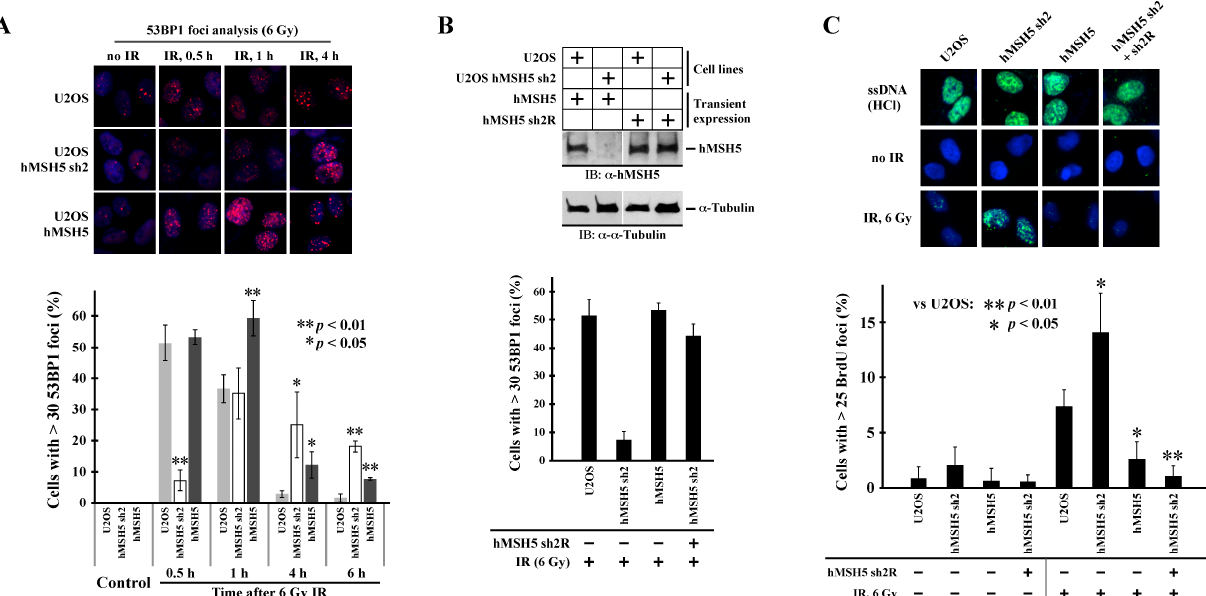
Figure 5. Effects of hMSH5 on IR-induced 53BP1 foci formation and DSB end resection. ( A ) Exami- nation of IR-induced 53BP1 foci formation in U2OS, U2OS/hMSH5 sh2, and U2OS/hMSH5 cells at 0.5, 1, 4, and 6 h after irradiation with 6 Gy IR. A representative image panel of 53BP1 foci for each cell line is provided. Thirty foci per cell were used as the cutoff to analyze the effect of hMSH5 on IR-induced 53BP1 foci formation. Bar graphs are used for data presentation, and asterisks are used to designate significant differences among all three cutoff categories. Error bars are standard deviations determined from three counts, each with 100 cells. ( B ) Rescuing of IR-induced 53BP1 foci formation by RNAi-resistant hMSH5 (sh2R) at 30 min post IR treatment. Upper panel shows immunoblotting analysis of RNAi-resistant hMSH5 expression in U2OS/hMSH5 sh2 cells. ( C ) Examination of ssDNA formation in U2OS, U2OS/hMSH5 sh2, U2OS/hMSH5, and hMSH5-complemented U2OS/hMSH5 sh2 cells. A panel of representative BrdU immunostaining images is included to show equivalent levels of BrdU incorporation in all cell lines ( top ) and the IR-induced BrdU foci formation (ssDNA) at 30 min after exposure to 6 Gy IR ( middle and bottom ). Percentages of cells with >25 BrdU foci, determined by three counts, each with 100 cells, are graphically displayed with error bars representing standard deviations. Statistical significance was determined by Student’s two-tailed t